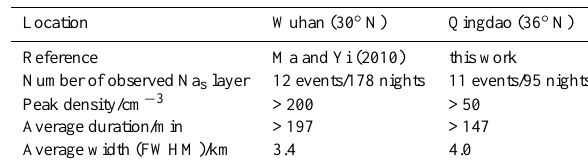
Table 5. Statistical characteristics of high-altitude (above 105km) Na s layers observed at Qingdao and Wuhan,